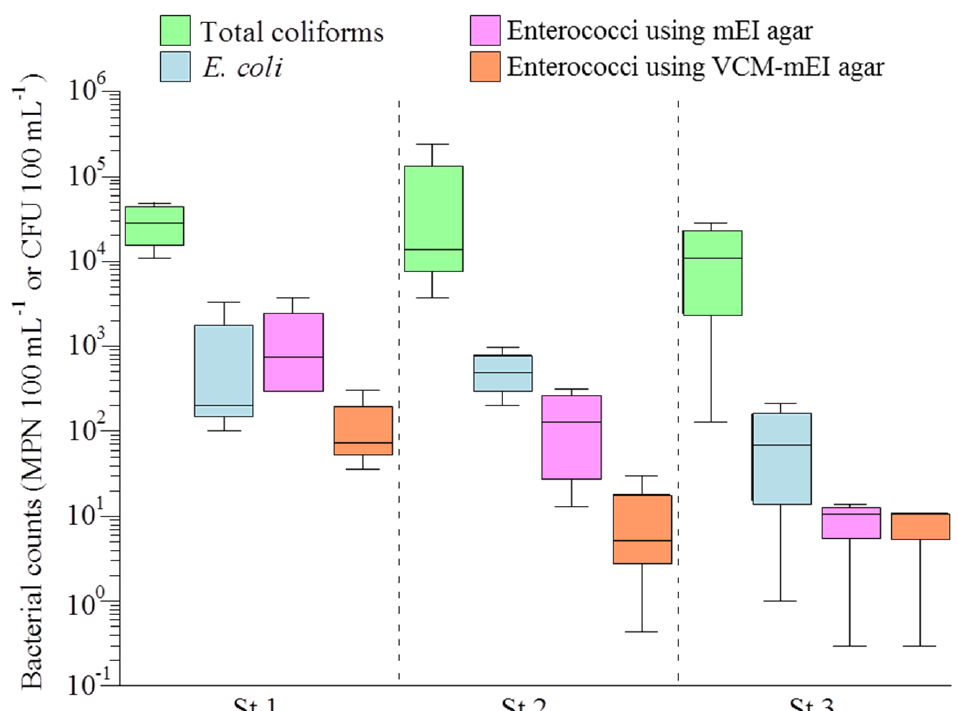
Figure 2. Bacterial counts at each sampling site during the study period. The green bar indicates the total coliform, the blue bar indicates the E. coli , the pink bar indicates the enterococci using mEI agar, and the orange bar indicated the enterococci using VCM-mEI agar. The symbols indicate the following: box, 25–75th percentile; horizontal line, median; and whiskers, minimum-maximum value.